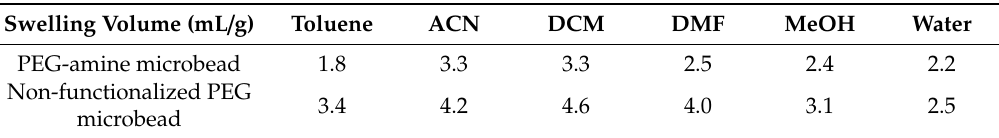
Figure 4. Energy dispersive X-ray spectroscopy (EDS) analysis of PEG-amine microbeads (black) and non-functionalized PEG microbeads (red). Table 1. Swelling volume of PEG microbeads with or without amine functionalization in the various